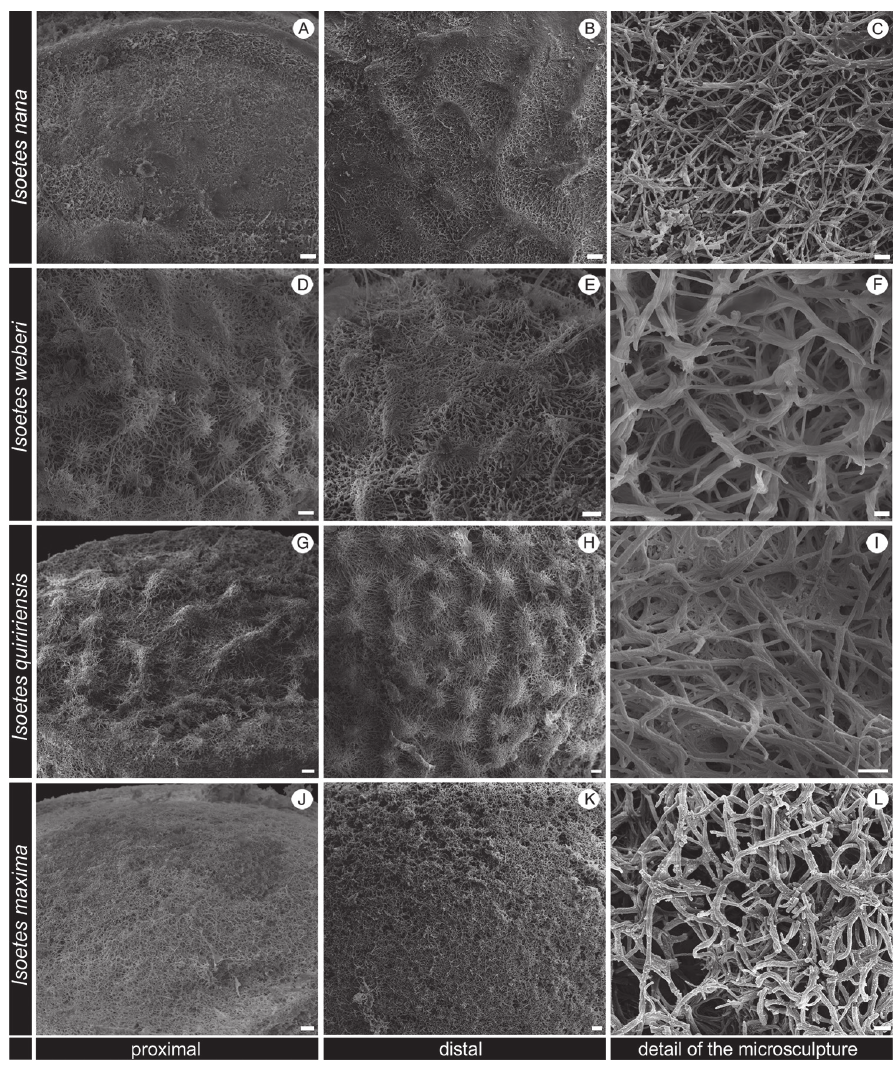
Figure 7. SEM images of the megaspore of Isoetes nana (Ule 98, G), I. weberi (Herter 95840, US), I. quiririensis (Pereira 635, UPCB), I. maxima (Pereira 631, UPCB). A–B Details of the macrosculpture of the megaspore of I. nana A Proximal view B Distal view C Details of the microsculpture of the megaspore of I. nana in distal view showing the terminal ends of anastomosed bars joined forming bacillae or more rarely echinulae D–E Details of the macrosculpture of the megaspore of I. weberi D Proximal view E Dis- tal view F Details of the microsculpture of the megaspore of I. weberi in distal view showing the terminal ends of anastomosed bars joined forming echinulae G–H Details of the macrosculpture of the megaspore of I. quiririensis G Proximal view H Distal view I Details of the microsculpture of the megaspore of I. quiririensis in distal view showing the terminal ends of anastomosed bars joined forming echinulae or rare- ly bacillae J–K Details of the macrosculpture of the megaspore of I. maxima J Proximal view K Distal view L Details of the microsculpture of the megaspore of I. maxima in distal view showing the terminal ends of anastomosed bars joined forming bacillae. Scale bars: A, B, D, E, G, H, J, K = 10 µm; C, F, I, L = 1